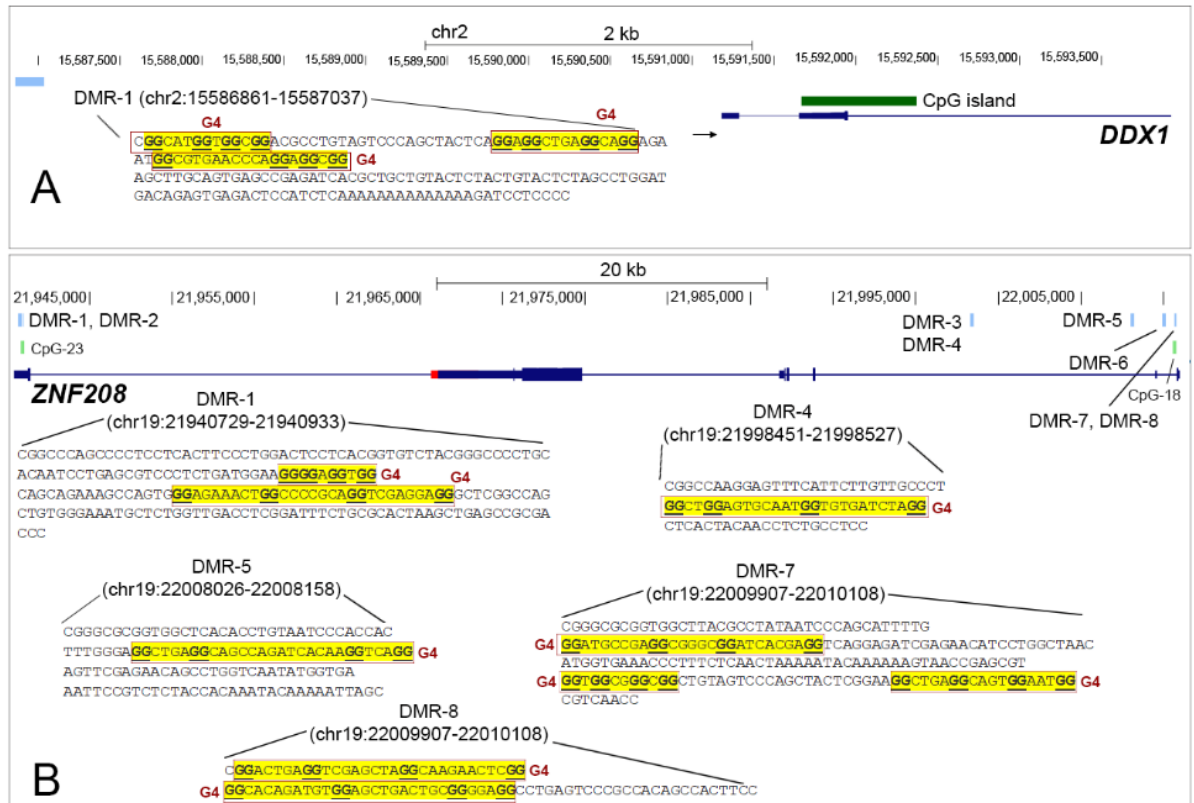
Figure 6. We observed frequent overlaps between hypomethylated DMRs and G4FS at ( A ) the promoter of DDX1 , and the body of ( B ) ZNF208 and ( C ) RAP1A . ( D ) A single G4FS was observed, overlapped to the hypermethylated DMR of PIK3C3 , while no overlap was noticed at the DMR-1 of the TERF1 promoter. Abbreviations: DMR, differentially methyl- ated regions; G4FS, G quadruplex forming sequences. However, no G4FS was found in the DMR-1 of TERF1 . Nonetheless, similar to DDX1 , frequent overlaps between G4FS and hypomethylated DMRs were found at the bodies of